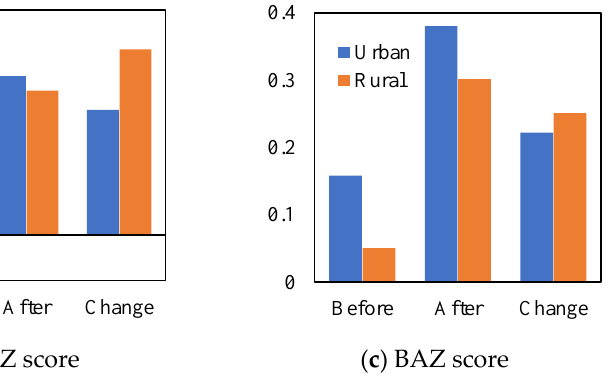
Table 3. Benchmark regression estimation results for the effect of household technology on child health.